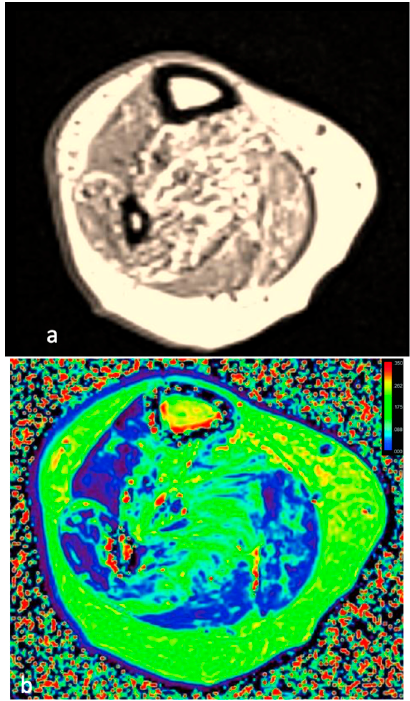
Figure 2. Axial T1w ( a ) image of a type III spinal muscular atrophy patient which shows massive fatty replacement of thigh muscles. Axial T2map image ( b ) shows very high T 2 relaxation time values of the corresponding muscle bellies. The mean T2map muscle value is 158 ms.